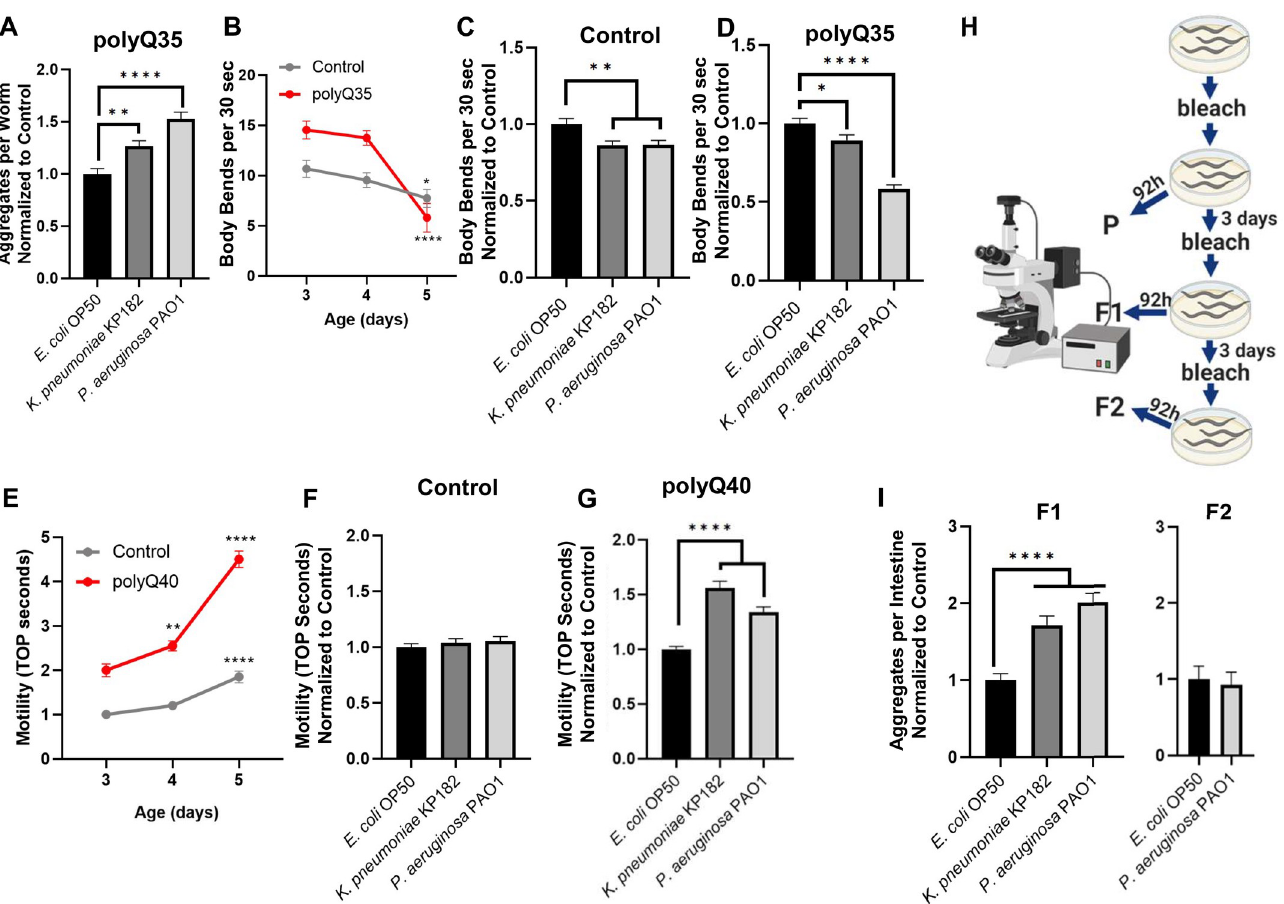
Fig 3. Colonization of the C . elegans intestine with human enteric pathogens influences proteostasis in a tissue non-autonomous manner. A) The effect of select bacteria on protein folding in the muscle. Data are represented as the average number of aggregates per worm normalized to E . coli OP50 control strain. Each bar is an average of three independent experiments with a total of 100 animals. B) Age-dependent decline in motility assessed by enumerating body bends per 30 seconds in muscle-specific polyQ35 and N2 control worms. The data are represented as the average number of body bends quantified on day 3–5 post- hatching in a total of 15 animals per each day. The effect of bacteria on the motility of C) control animals and D) animals expressing muscle-specific polyQ35. Data are represented as the average number of body bends per worm normalized to worms fed E . coli OP50 control strain. Each bar is an average of three independent experiments with a total of 45 animals. E) Age-dependent decline in motility assessed by increased TOP. The effect of bacteria on the motility of F) control animals and G) animals expressing neuron-specific polyQ40. Data are represented as the average TOP per worm normalized to animals fed E . coli OP50 control strain. Each bar is an average of three independent experiments with a total of 60 animals. H) A cartoon depicting experiments which demonstrated that bacterial colonization of the C . elegans intestine affects the F1 generation. I) Quantification of intestinal aggregates in the F1 and F2 generations from parental animals that were fed select test and control bacteria. Each bar represents the average number of aggregates per intestine normalized to the control ( E . coli OP50). Data are representative of three (F1) and one (F2) independent experiments with a total of 100 and 30 animals, respectively. Error bars represent SEM. Statistical significance was calculated using one-way ANOVA followed by multiple comparison Dunnett’s post-hoc test ( � p < 0.05, �� p < 0.01, ���� p < 0.0001). ( F25B3 . 3p ::Q40::YFP) [30]. The small size and high concentration of neurons preclude us